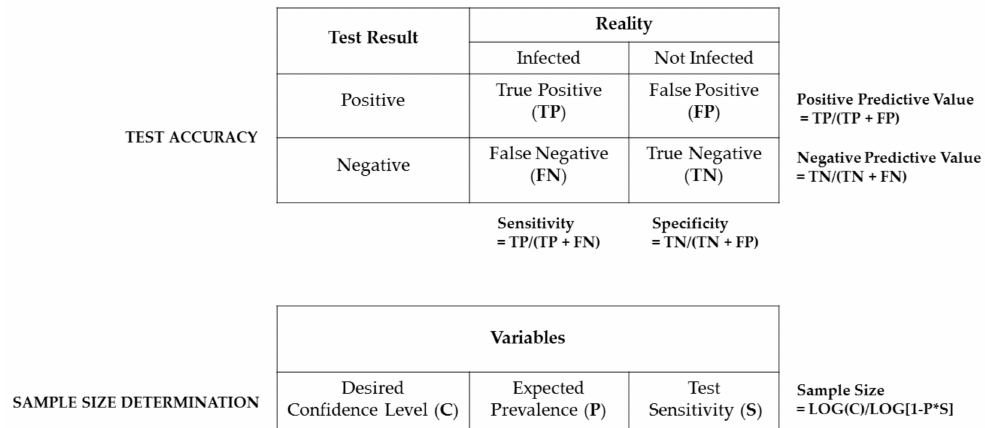
Figure 2. Schematic overview of the two main factors influencing the diagnostic success. The test accuracy is defined by its diagnostic sensitivity and specificity as well as the underlying positive and negative predictive values. All parameters can be calculated based on true positive (TP) and negative (TN) as well as on false positive (FP) and negative results (FN). The number of required samples necessary to detect an infectious agent is based on the desired confidence interval (C) expected pathogen prevalence (P) and the respective test sensitivity (S). Importantly, this calculation holds only true for colonies of at least 100 animals and free distribution of infections